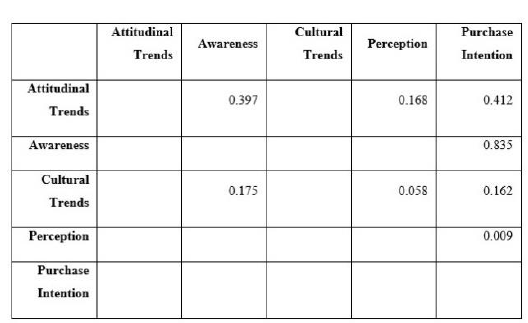
Table 4: Total Effects